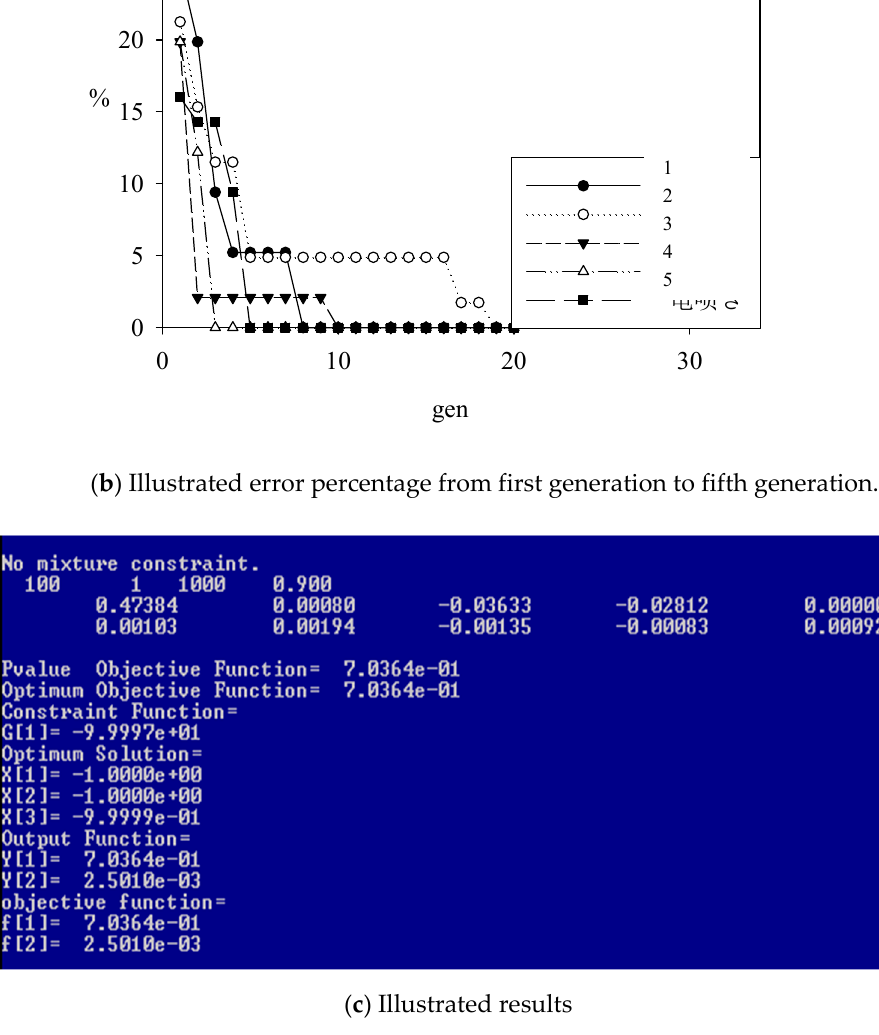
Figure 9. Illustrated OPSO process for the optimization problem.